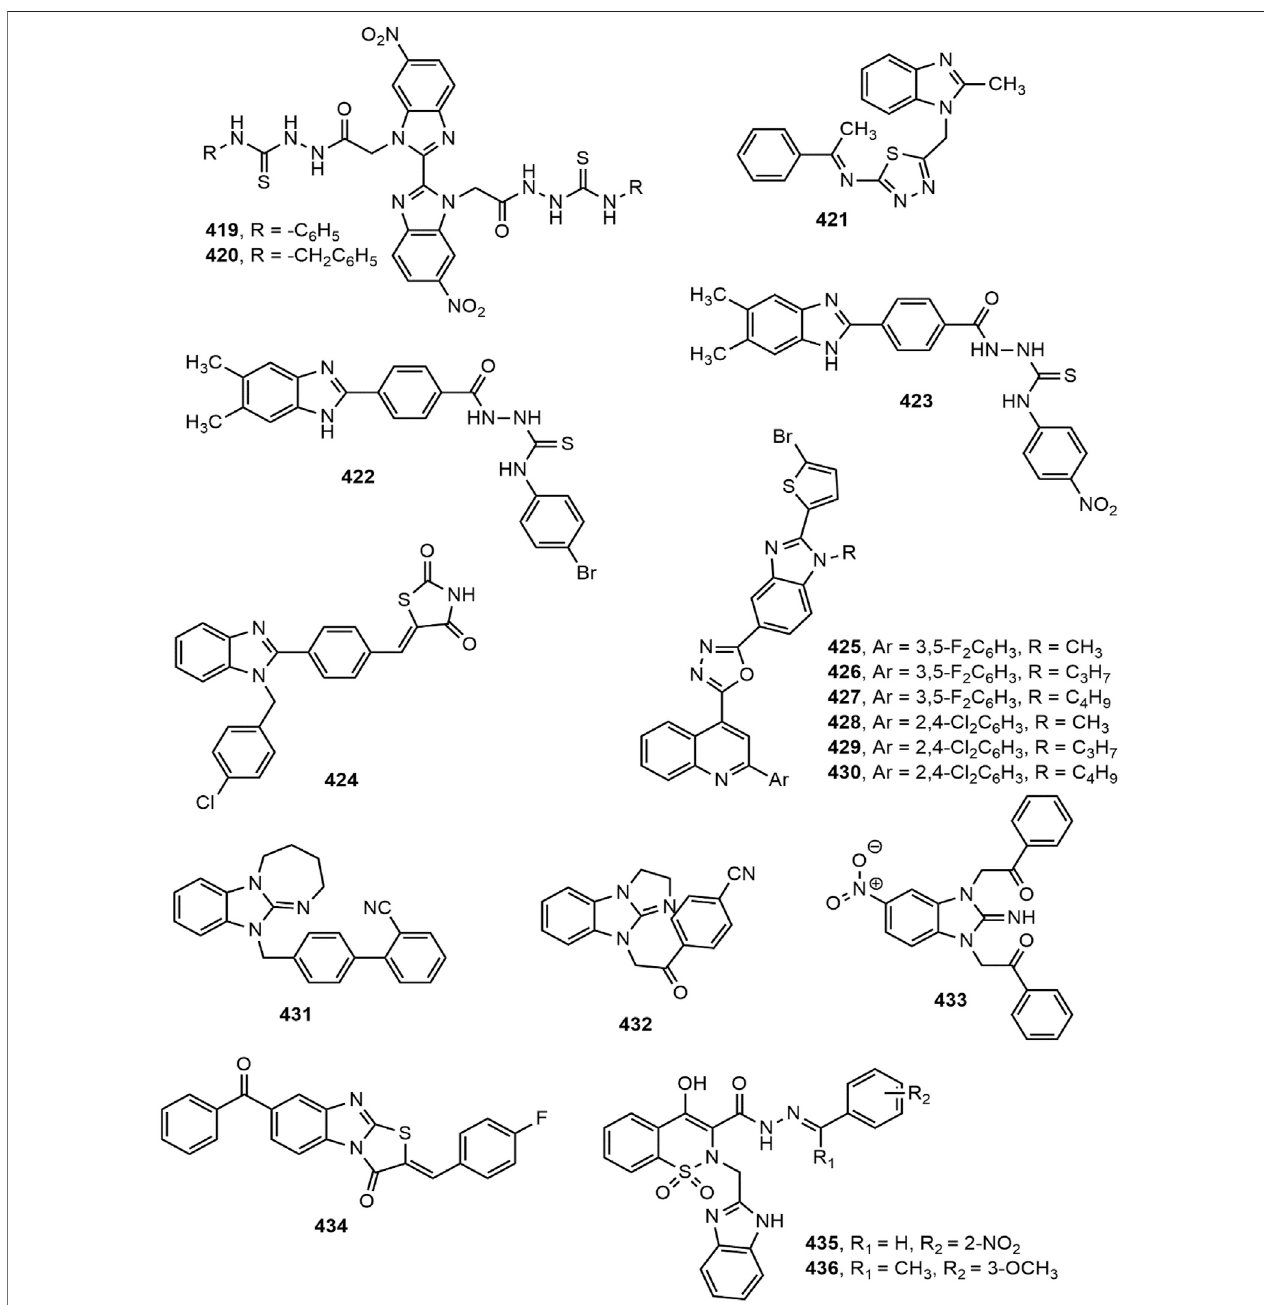
FIGURE 17 | Benzimidazole derivatives with antidiabetic